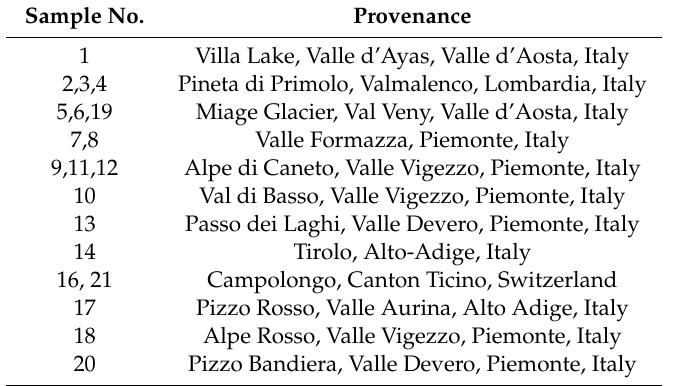
Table 1. Provenance of the twenty amphiboles analyzed with SEM-EDS and micro-Raman spectroscopy. Sample No. Provenance